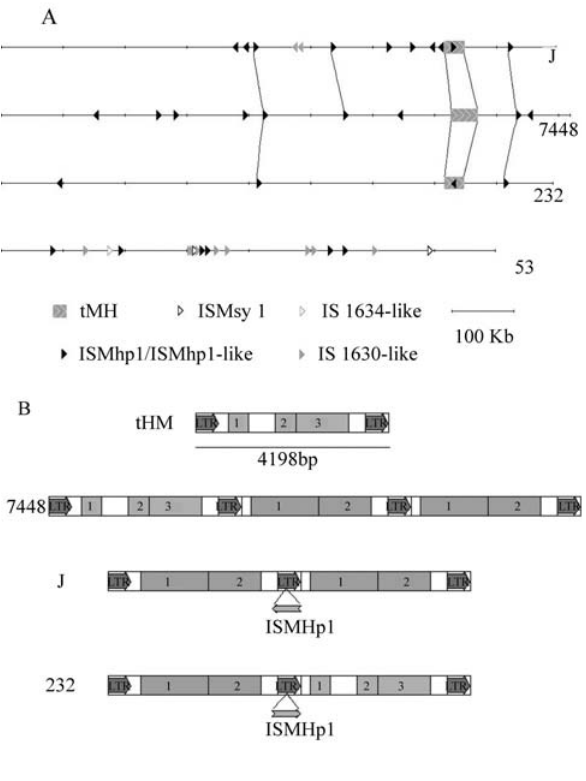
Figure 1 - A - An overview location of diverse transposable elements in J, 7448, 232 M. hyopneumoniae and M. synoviae genomes. Different arrow- heads symbolize the various ISs. The line connecting IS among genomes correspondstoelementsthatarehomologousinthedifferentgenomes. B - Structural features of the tMH element in M. hyopneumoniae . In the upper diagram the tHM is depicted as described by Harasawa (1995) with the Long Terminal Repeats (LTRs) and three ORFs. The complete element has 4193 base pairs. The remaining diagrams depict the arrangement of tMH in: the 7448 strain - in which three tMH elements are arranged in tan- dem and share adjacent LTRs; in the J and 232 strains - in which two tMH elements are arranged in tandem, and in the internal shared LTR, an ISMHp1 element is inserted. Note the opposite directions of the inserted ISMHp1 element for each